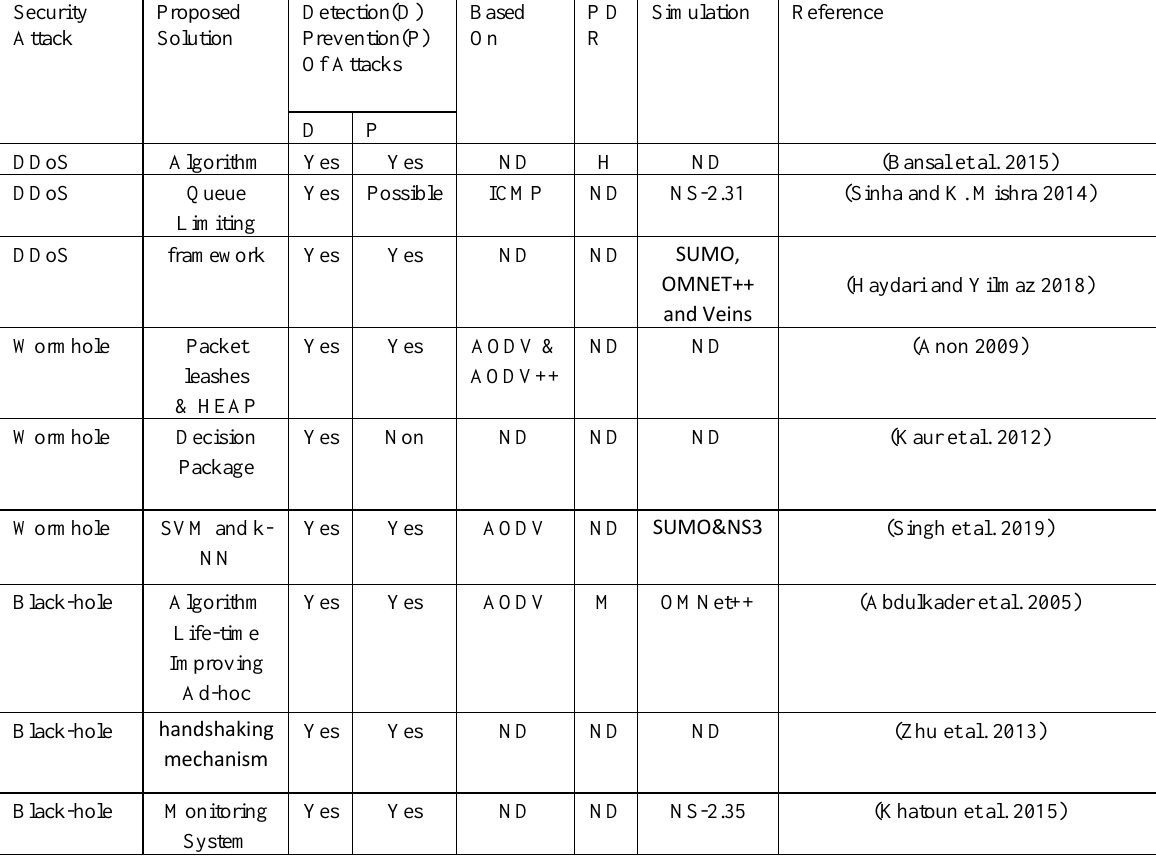
TABLE I. DETECTING AND PREVENTING SECURITY ATTACKS IN